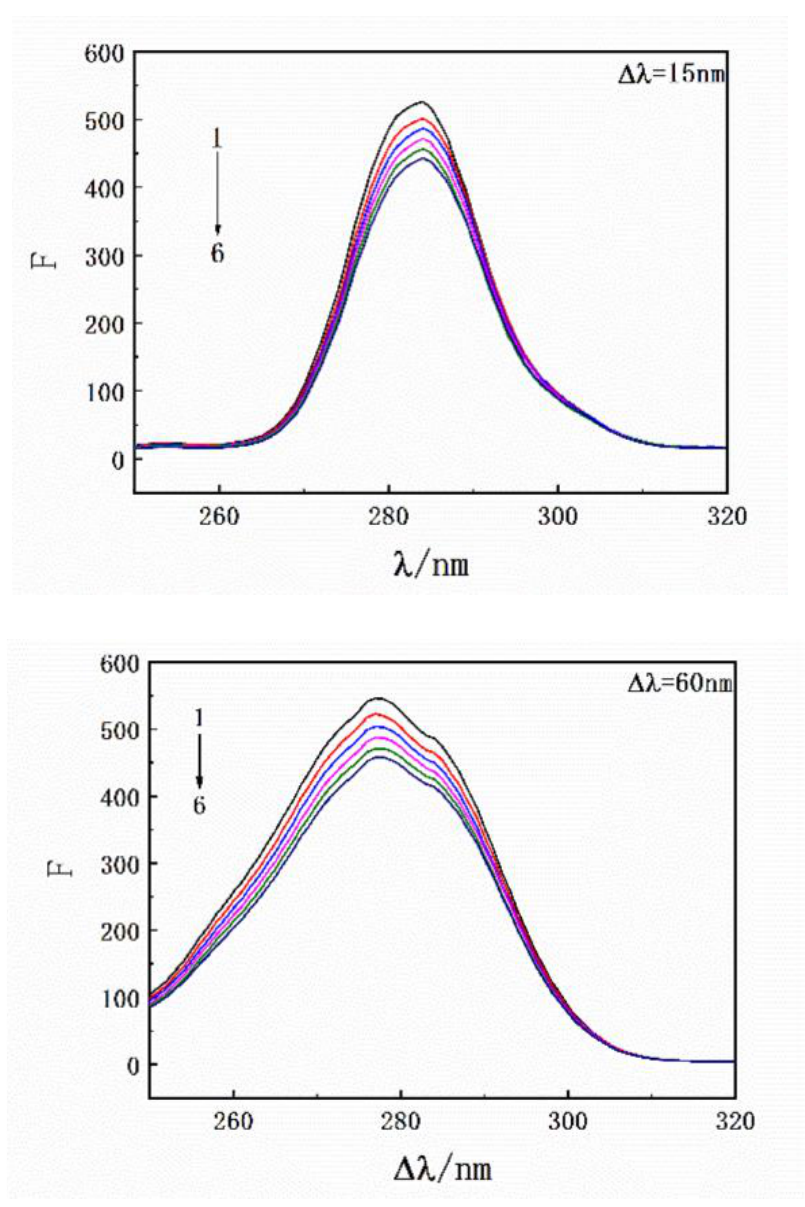
Figure 7. Synchronous fluorescence spectroscopy of HSA with an increase in drug